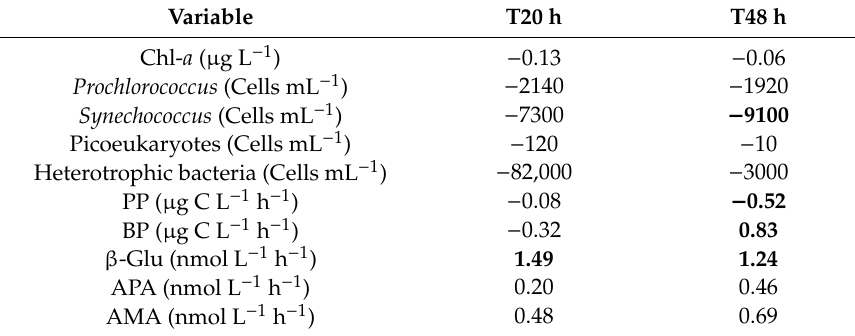
Table 1. The net response triggered by airborne microbes in the northern Red Sea (NRS) seawater 24–48 h post addition. Values were calculated as the di ff erence between the “live dust” and “UV-treated dust”. Statistically significant di ff erences are highlighted in bold ( p <